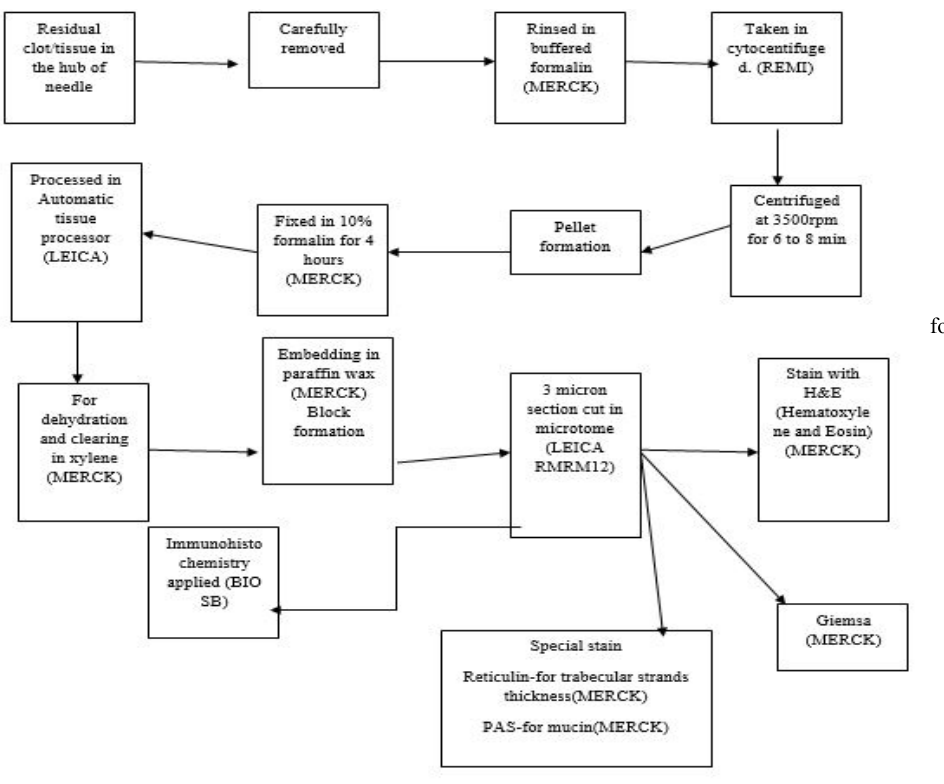
to show cell block formation methodology in our